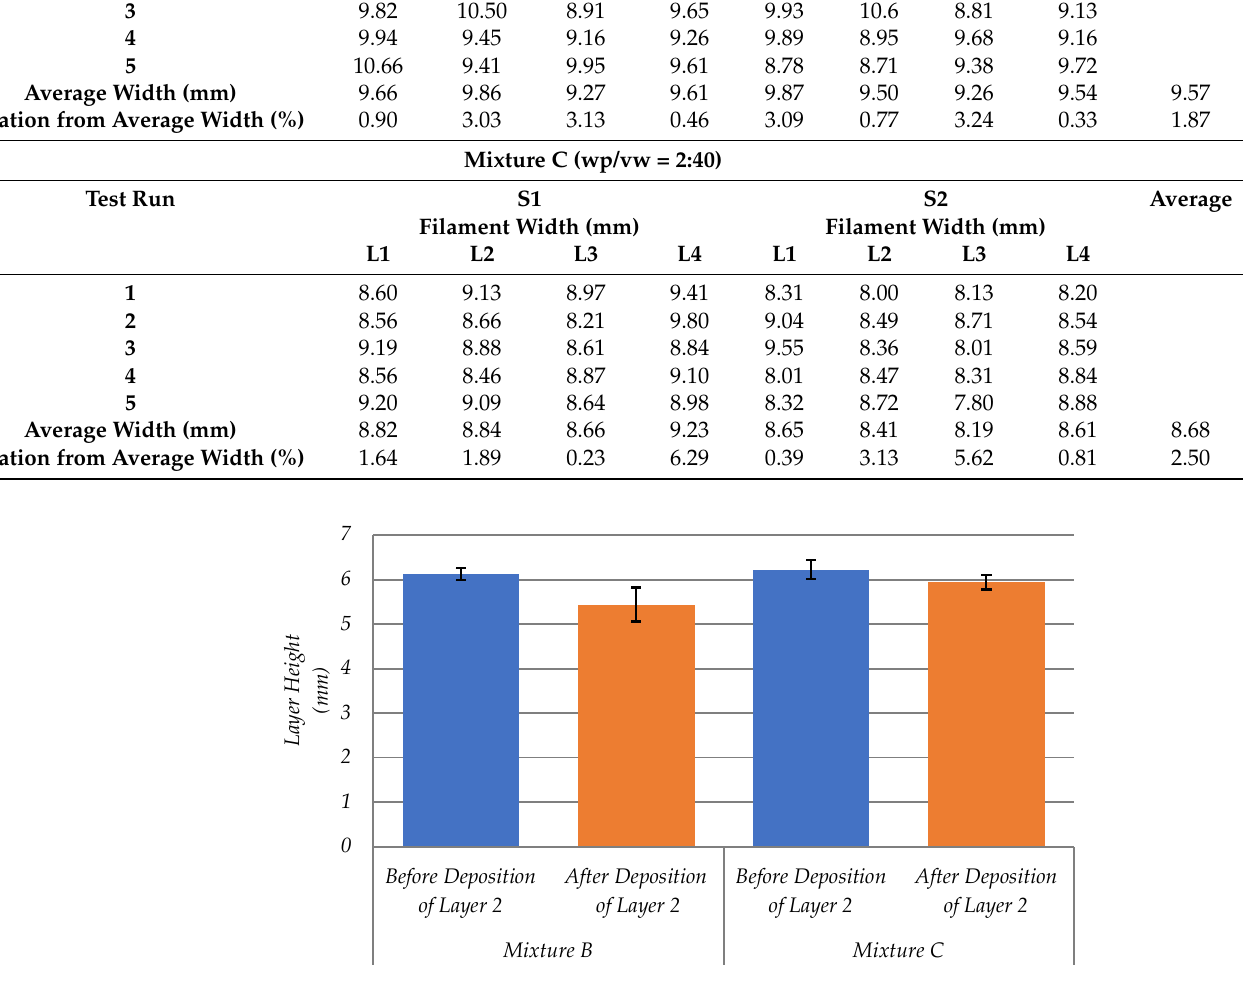
Figure 9. Height changes in layer 1 after depositing layer 2.